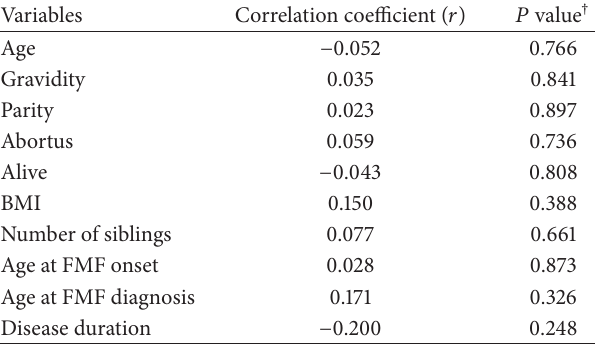
Figure 1: Anti-M¨ullerian hormone levels according to groups (control and FMF) and M694V positivity-negativity in FMF group.